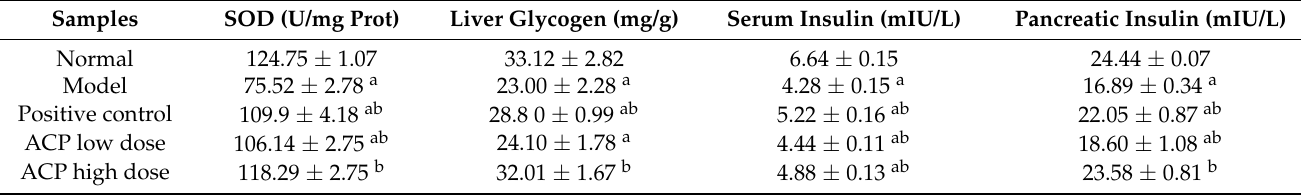
Table 4. Effects of ACP on SOD, liver glycogen, and insulin in mice.